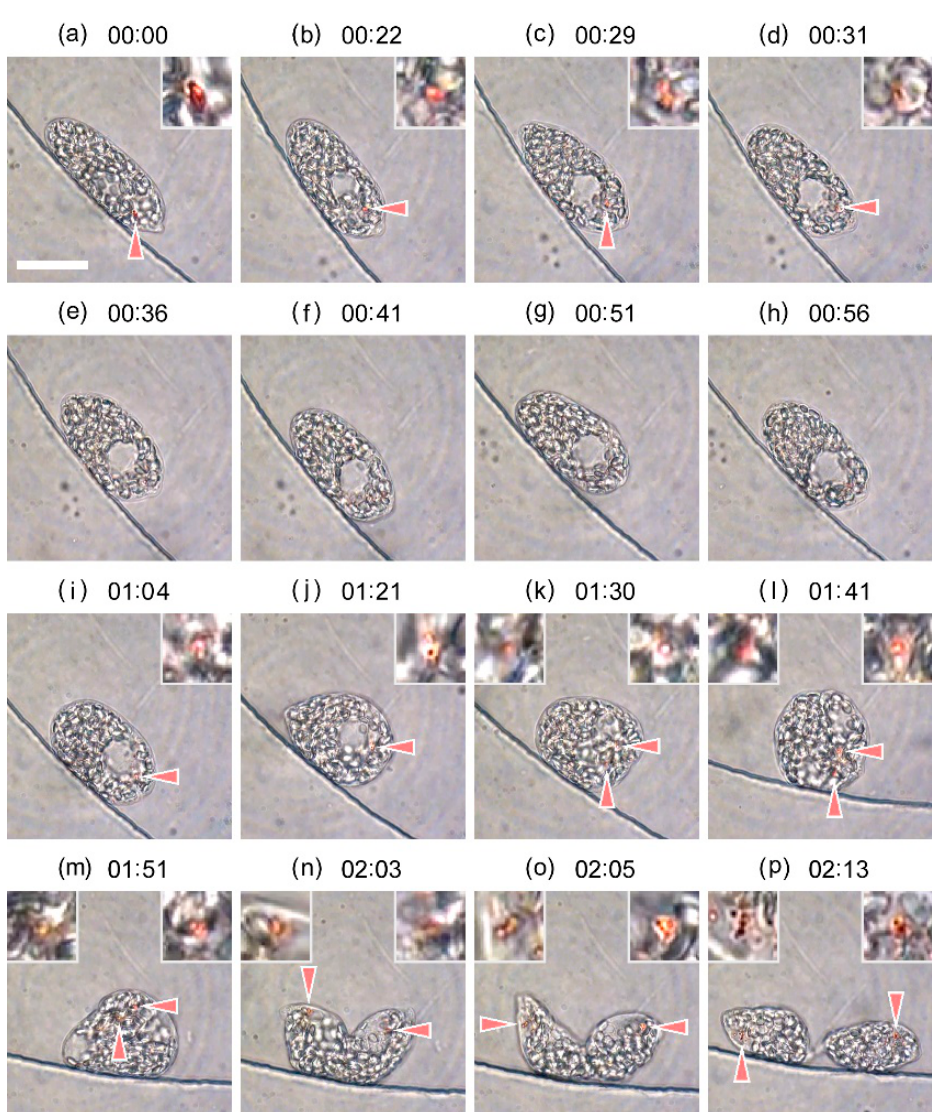
Figure 5. Images extracted from the video recording of the experiment depicted in Figure 3. ( a ) 21.24 h, ( b ) 21.60 h, ( c ) 21.72 h, ( d ) 21.75 h, ( e ) 21.83 h, ( f ) 21.92 h, ( g ) 22.08 h, ( h ) 22.17 h, ( i ) 22.30 h, ( j ) 22.58 h, ( k ) 22.73 h, ( l ) 22.92 h, ( m ) 23.08 h, ( n ) 23.28 h, ( o ) 23.32 h, and ( p ) 23.46 h. Time index given in the figure is shifted as reference; 00:00 (hh:mm) corresponds to 21.24 h in Figure 3. The eyespot indicated by arrow is enlarged by four times in the inset. Scale bar, 20 μ m. Dynamic evo- lution of cell division is provided in the supplementary movie S3.